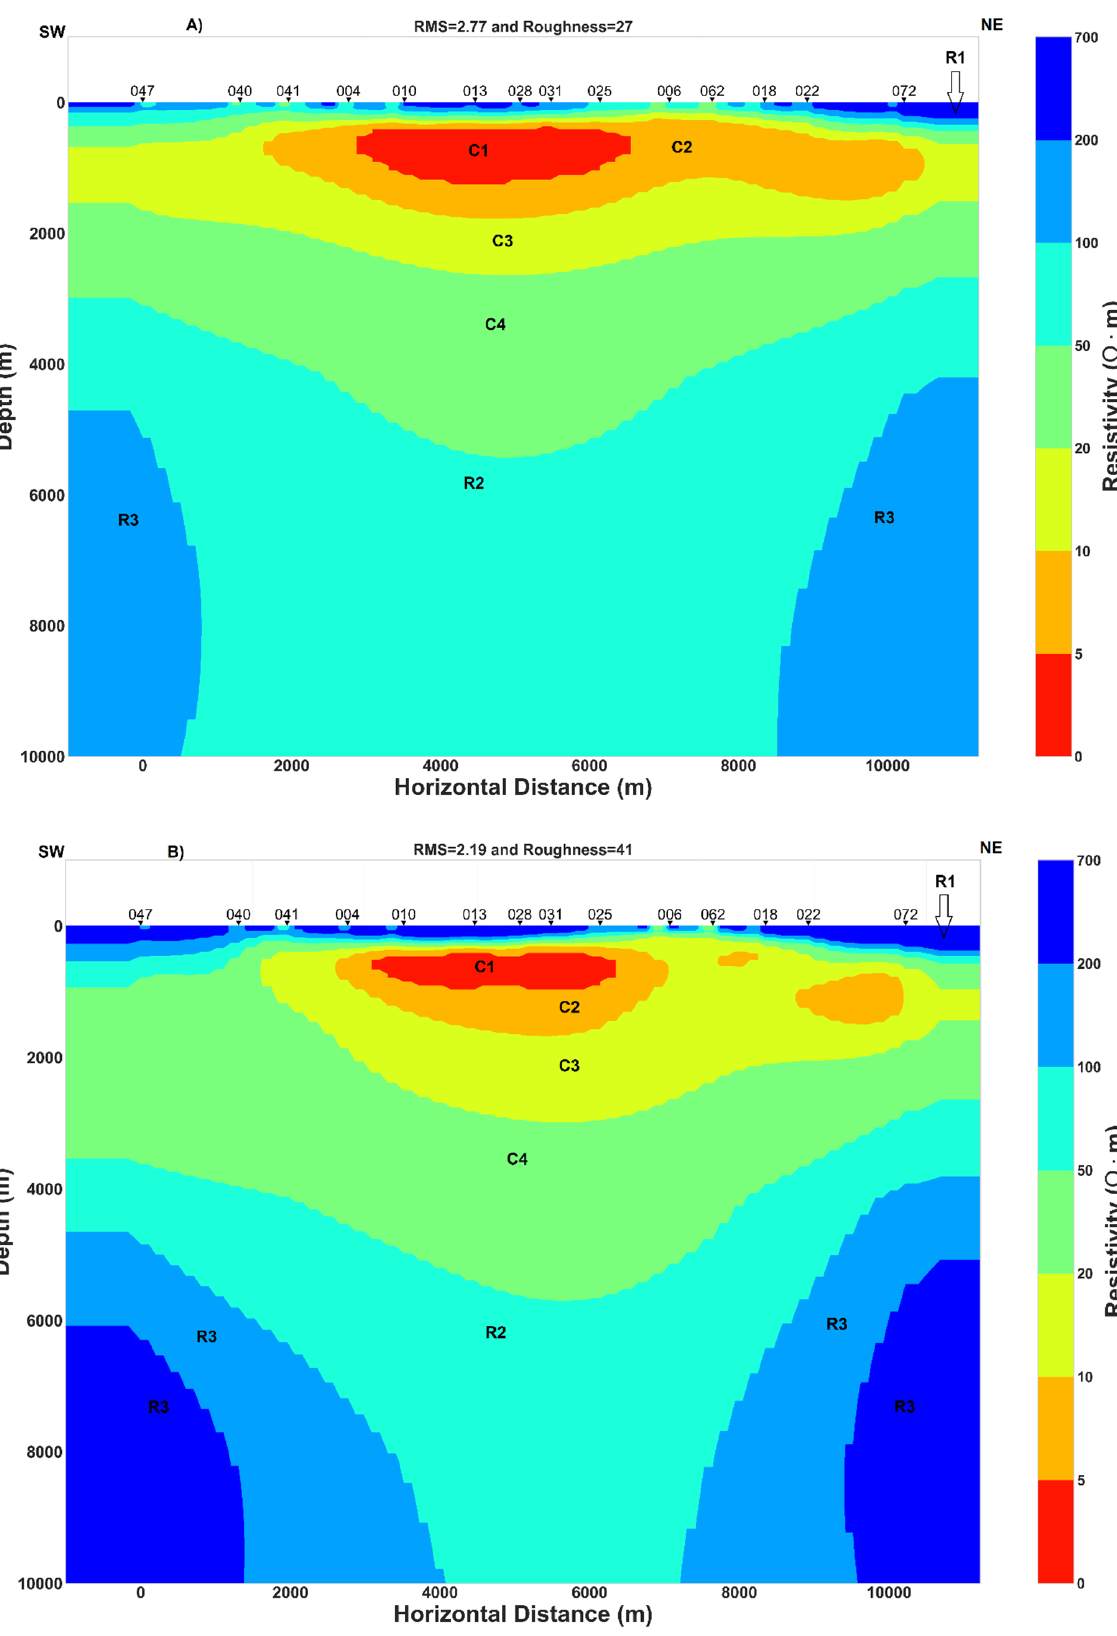
Figure 9. Cont . Figure 9.